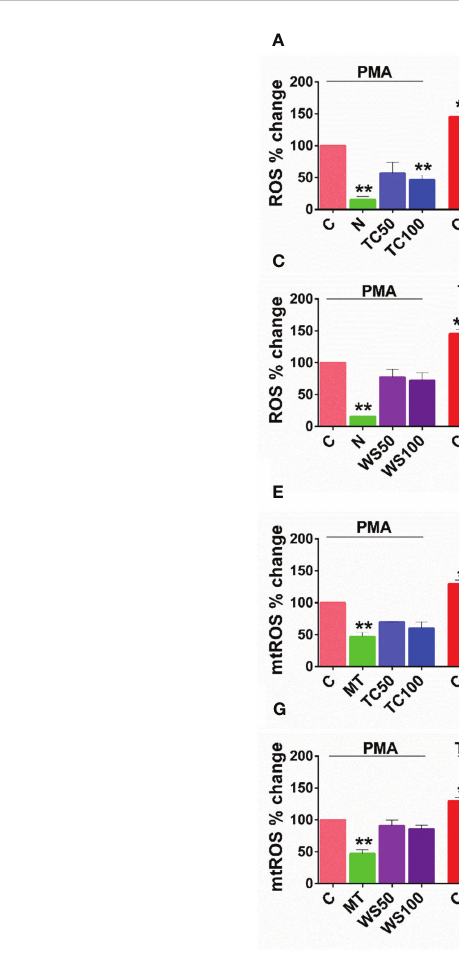
FIGURE 3 Effect of WS and TC on TRLM primed-PMA/ionomycin induced NETs formation in human PMNs. After pre-incubation with different concentrations TC and WS, PMNs were treated with TRLM (10 µg/ml) for 30 min and stimulated with sub-maximal concentration of PMA (12.5 nM) and